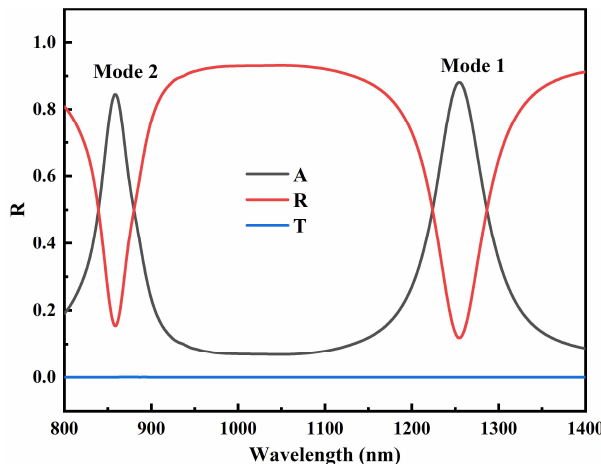
Figure 2. Absorption (A), reflection (R) and transmission (T) spectra of the proposed